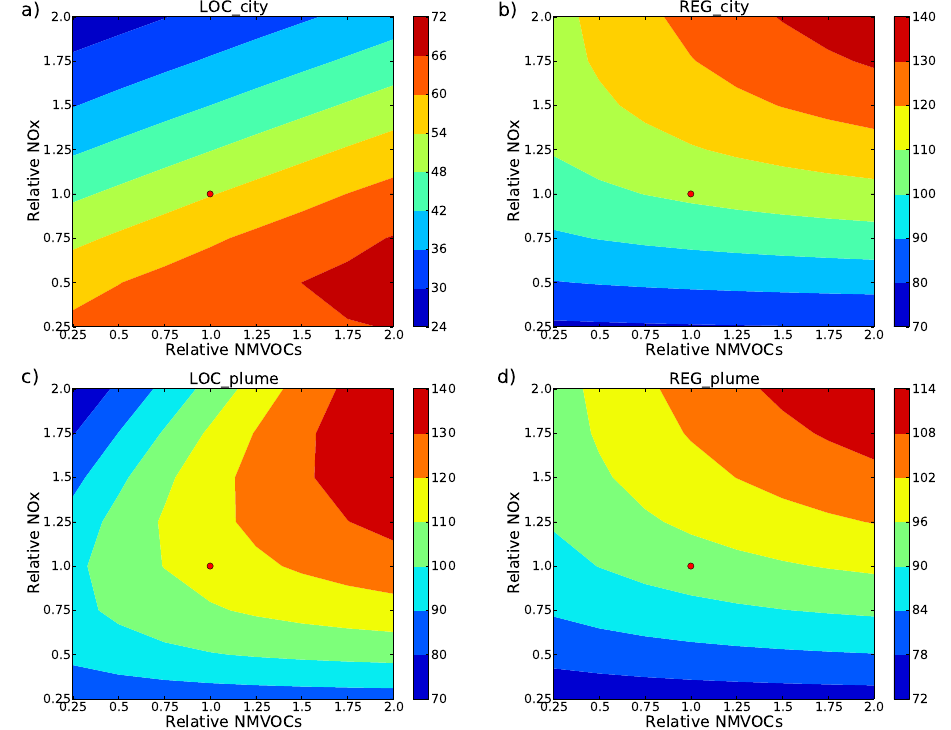
Figure 5. Isocontours of maximum ozone concentrations over downtown Paris (top panels) and over the entire modeling domain (IdF) (bottom panels) as a function of ozone precursor emissions. Axis units are the coefficients of emission changes (in moleculescm − 2 s − 1 ) with respect to their baseline values (point 1.0, 1.0). Isopleths on the left are modeled with the LOC simulation and on the right with the REG